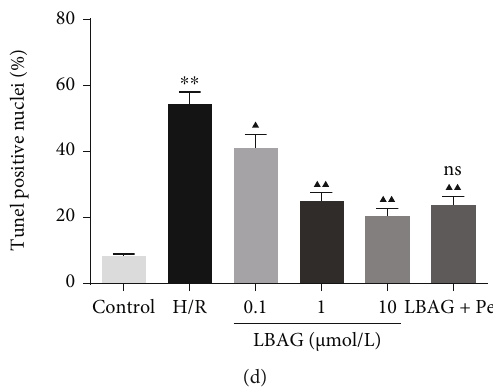
Figure 7: E ff ect of LBAG on the cell apoptosis of H/R-injured H9c2 cells. (a, b) Representative photographs of fl ow cytometry using FITC/ PI double staining in H/R-injured H9c2 cells treated with LBAG. (c, d) Representative photographs of TUNEL assay in LBAG-treated H/R- injured H9c2 cells. Apoptosis index signi fi cantly decreased following LBAG treatment in H/R-injured cardiomyocytes. ∗ P < 0 : 05 and ∗∗ P < 0 : 01 vs. control group. ▲ P < 0 : 05 and ▲▲ P < 0 : 01 vs. H/R group. No signi fi cance (ns) vs. 10 μ mol/L LBAG